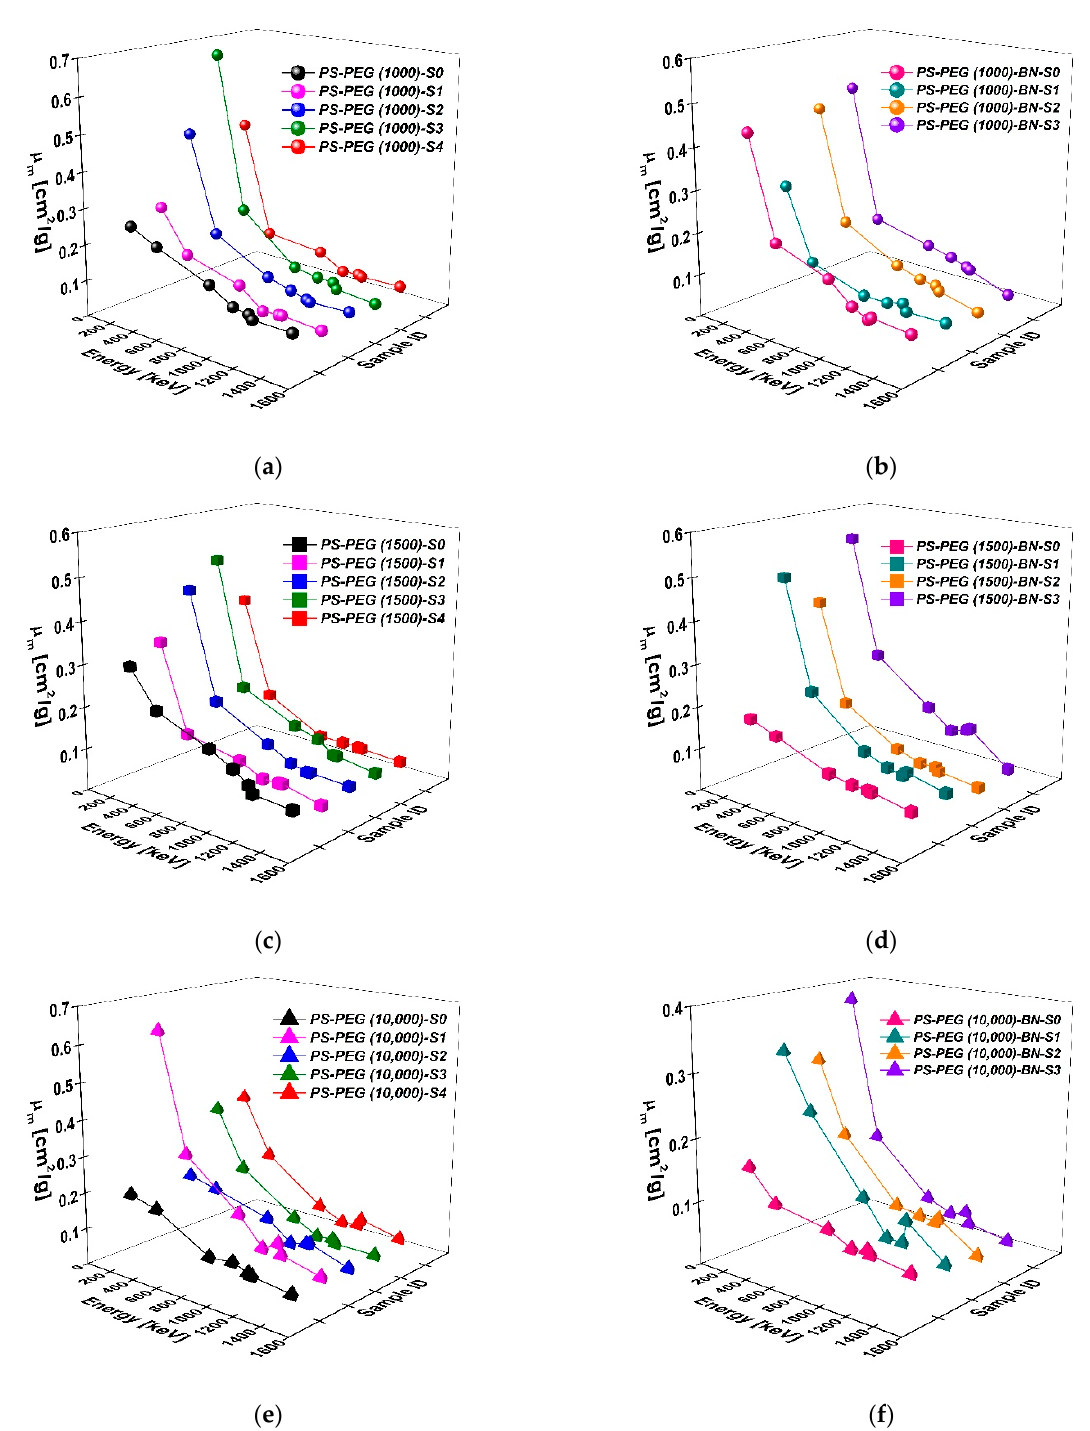
Figure 7. The MACs values of the PbO doped the crosslinked PS-b-PEG block copolymers and the PbO doped the PS-b-PEG-BN nanocomposite materials at different gamma radiation energies (from 121.782 keV to 1408.006 keV) of 152 Eu : ( a ) PS-PEG (1000)-S0,S1,S2,S3,S4; ( b ) PS-PEG (1000)-BN-S0,S1,S2,S3; ( c ) PS-PEG (1500)-S0,S1,S2,S3,S4; ( d ) PS-PEG (1500)-BN-S0,S1,S2,S3; ( e ) PS-PEG (10,000)-S0,S1,S2,S3,S4; ( f ) PS-PEG (10,000)-BN-S0,S1,S2,S3.